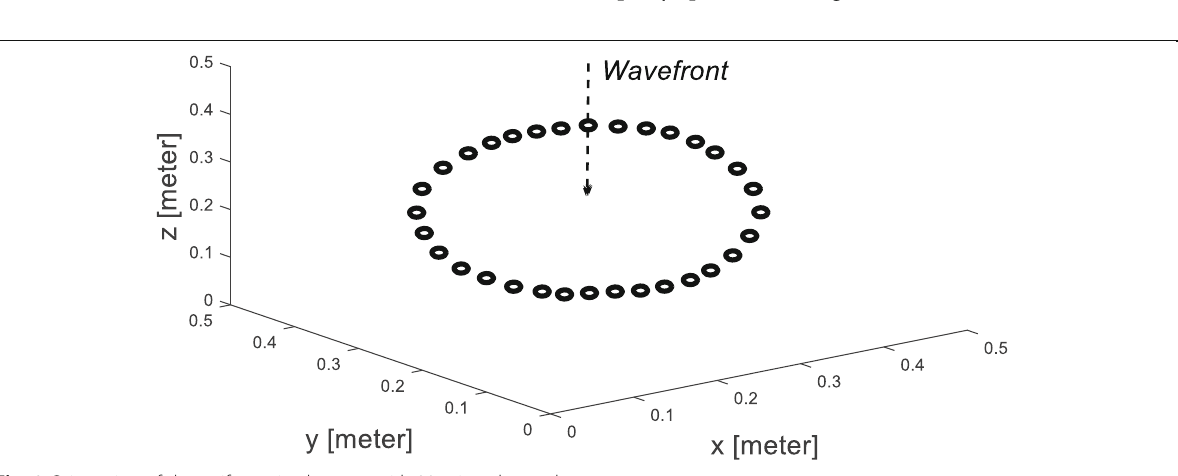
Fig. 2 Orientation of the uniform circular array with 32 microphone